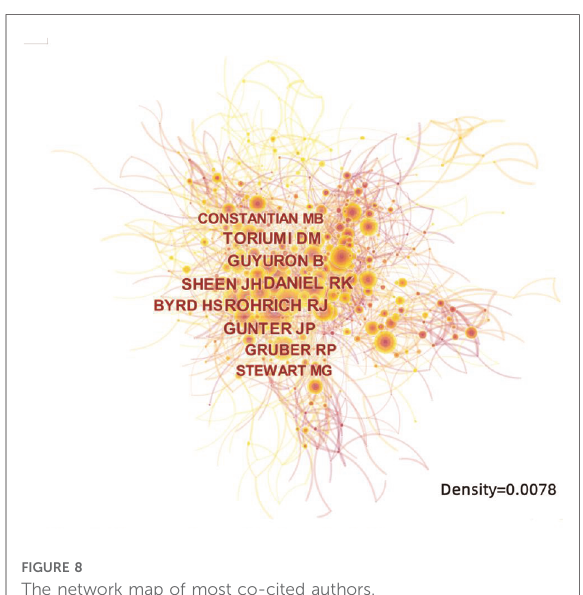
FIGURE 8 The network map of most co-cited